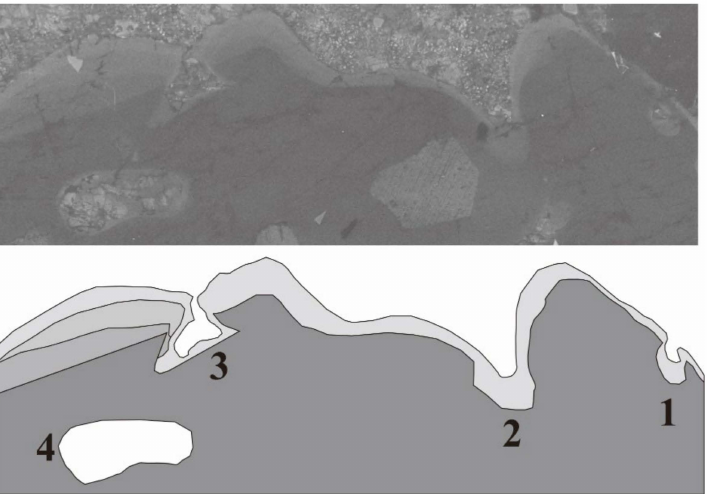
Figure 6. Sample H13-2 of magmatic quartz porphyry from Huangshaping showing the lobate depressions. Some of the impediments (4) are so deep that they look like inclusions, and growth zones are adapted the shape of these embayments